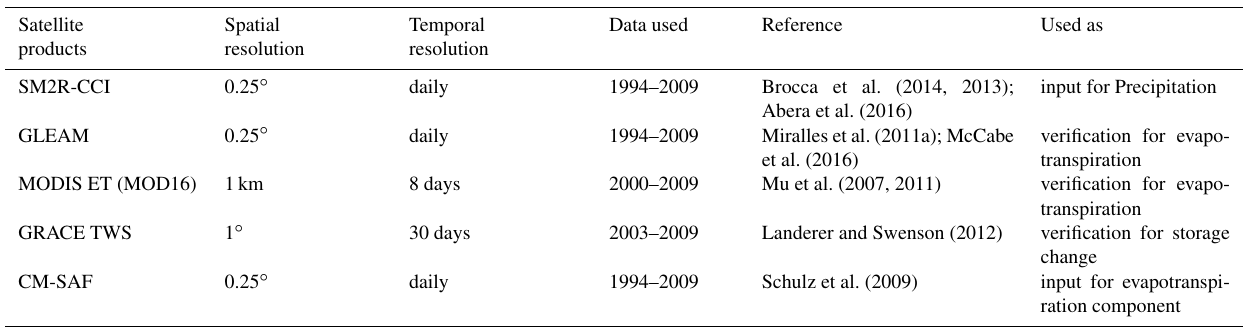
Table 2. Short summary of the list of remote sensing products used in this study. Satellite